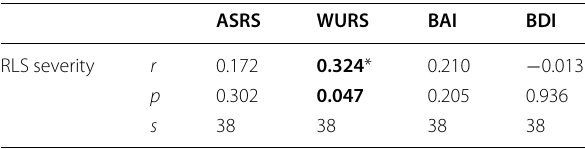
Table 3 Relationship between RLS severity and ASRS, WURS, BAI, and BDI in ADHD